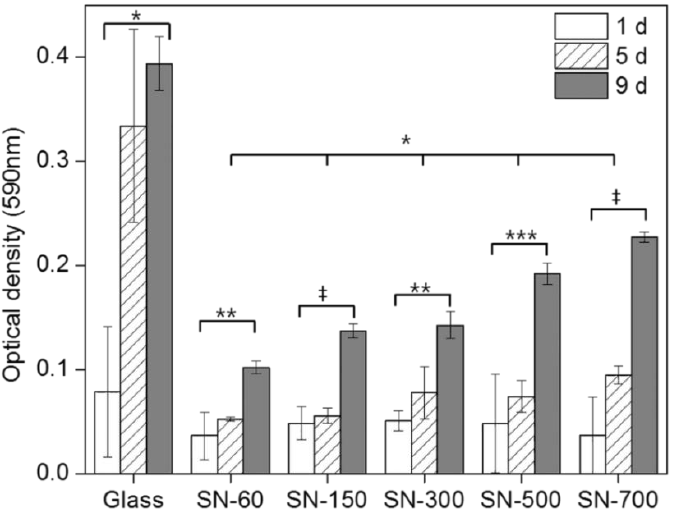
Figure 2. Viability of rat muscle-derived stem cells (rMDSCs) grown on SN and glass at 1, 5, and 9 days, measured by MTT assay. Cytotoxicity of substrates was analyzed by one-way ANOVA with Bonferroni’s multiple comparison (* p < 0.05, ** p < 0.01, *** p < 0.005, ‡ p < 0.001).